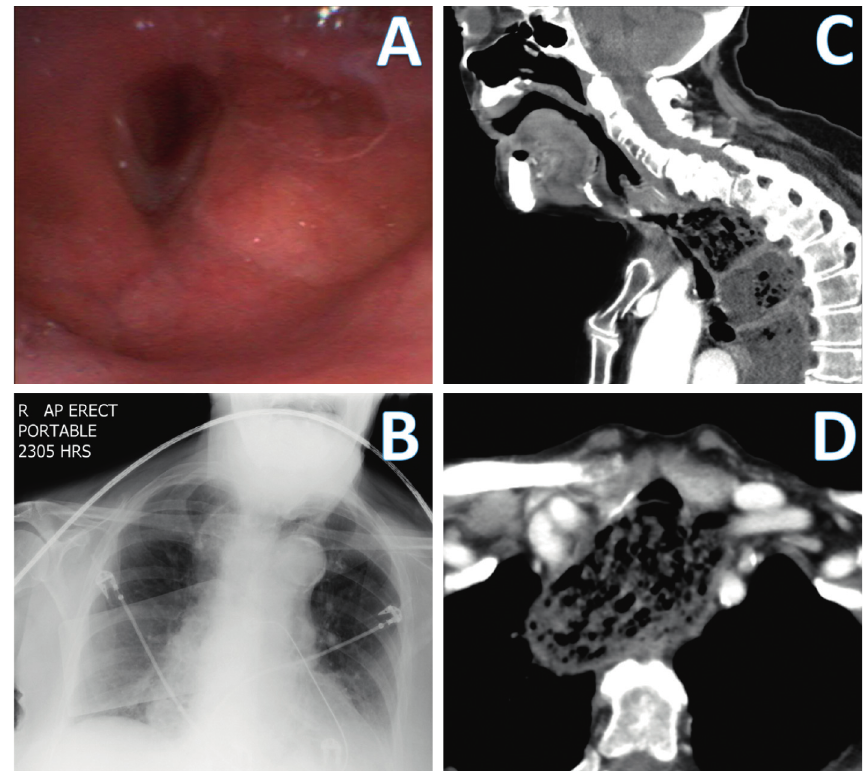
Figure 1: (a) Bronchoscopic image of the laryngeal inlet showing laryngeal oedema. (b) Anterior-posterior view of erect portable chest X- ray. (c) Sagittal view of CTneck showing massively dilated oesophagus and anteriorly displaced trachea and larynx. (d) Axial view of CTneck at the level of clavicles showing massively dilated oesophagus compressing the trachea